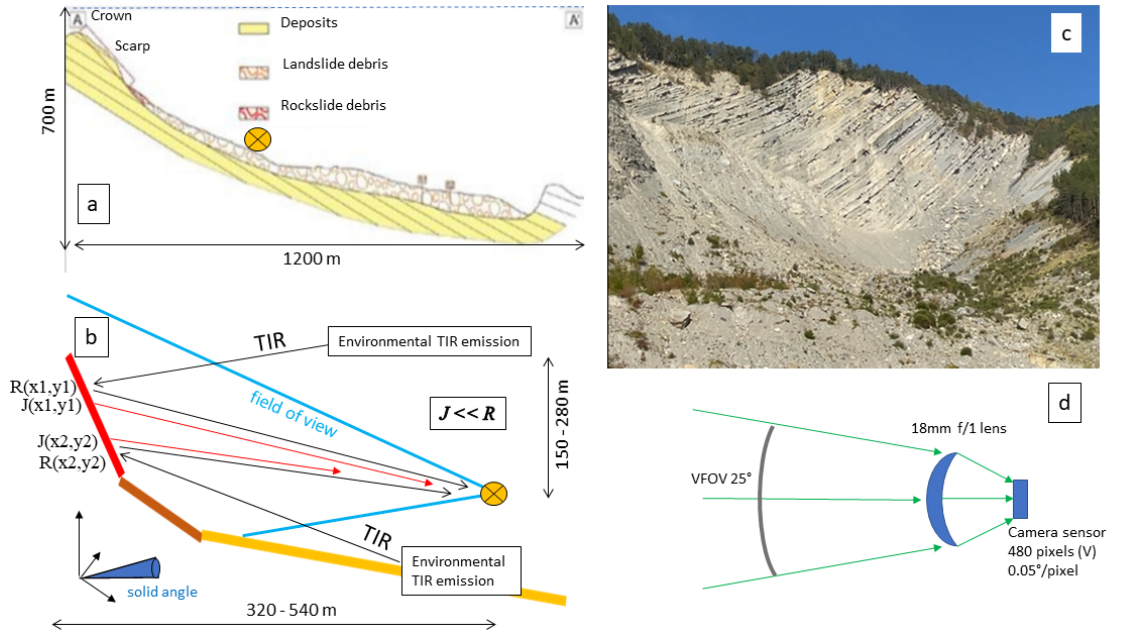
Figure 2. ( a ) Cut view of the landslide and its constituents with the distance of the zone that is affected by the landslide and the height of the landslide. ( b ) Theoretical model of the reflection and the emission of the elements of the landslide projected in the pixel (x,y) of the TIR camera detector with the distance and height of the detector respect the landslide. ( c ) Area corresponding to the field of view of the TIR camera, cropped from a photograph in the visible range taken with a smartphone in Figure 1c. ( d ) Geometrical optics model of the vertical field of view of the TIR